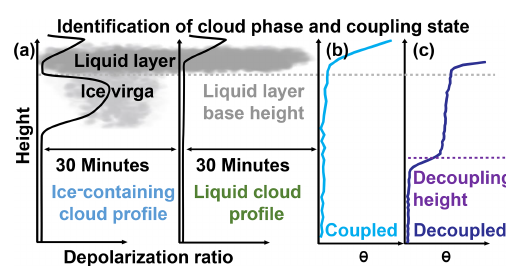
Figure 2. Sketch of the applied method: (a) shows two example profiles of the lidar volume depolarization ratio. In the first profile an ice virga is present below a liquid layer. Due to the ice below the liquid layer (high depolarization), the first 30min are classified as an ice-containing cloud profile. Without ice falling out of the cloud, only the liquid layer is present (low depolarization below the liquid layer). In the presence of ice, the liquid layer base height is characterized by a strong decrease in depolarization as the signal is now dominated by the return of the liquid droplets. Within the liquid layer the depolarization increases again due to multiple scattering. In (b) and (c) two profiles of θ are depicted, with (b) illustrating a coupled cloud and (c) a decoupled cloud. Additionally, in (c) the decoupling height is marked.